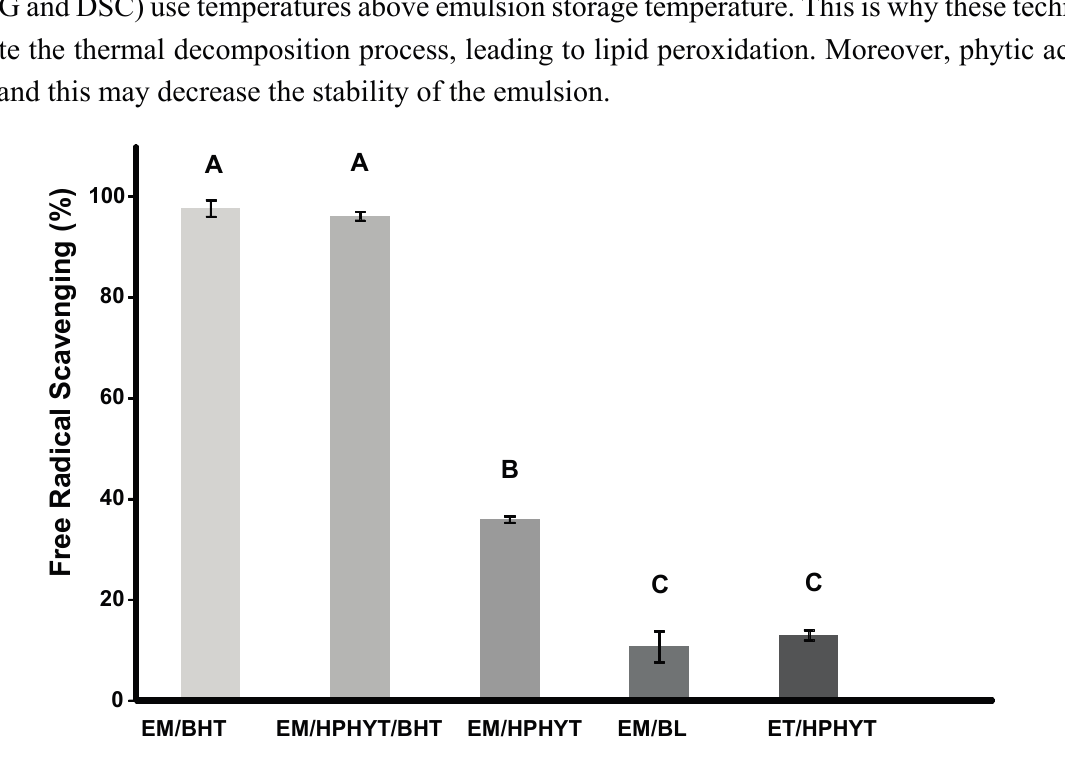
Figure 4. Free radicals scavenging of samples: EM/BHT, EM/HPHYT/BHT, EM/HPHYT, EM/BL and ET/HPHYT. Results of antioxidant activity expressed as mean ± standard deviation. Different letters above the bars represent statistically significant differences between groups. The results were evaluated according to the One-Way ANOVA statistical test, followed by Tukey test for comparison between groups (significance level =